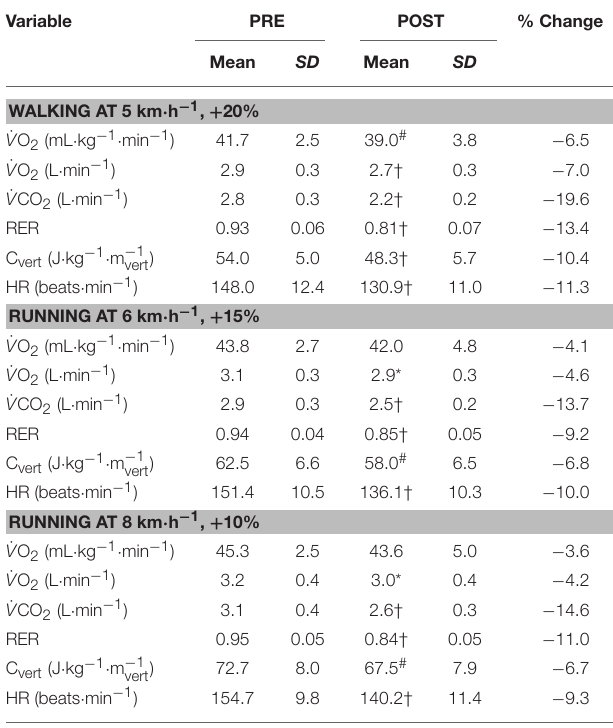
TABLE 1 | Changes in the metabolic data measured before (PRE) and after (POST) the MUM ( n = 19). Variable PRE